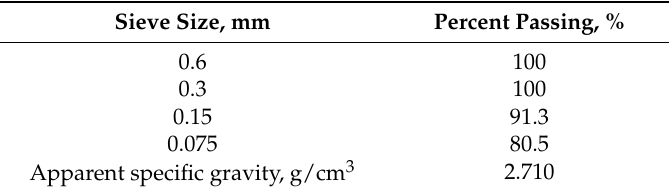
Table 2. Properties of limestone mineral